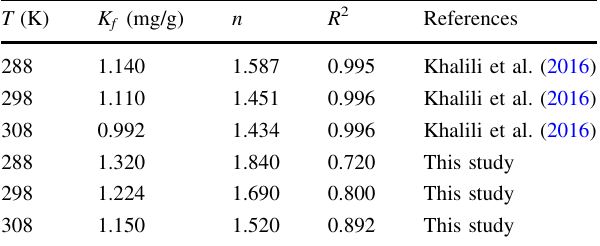
Table 2 Constant model parameters for Freundlich isotherm at dif- ferent temperatures compared with literature T (K) K f (mg/g) n R